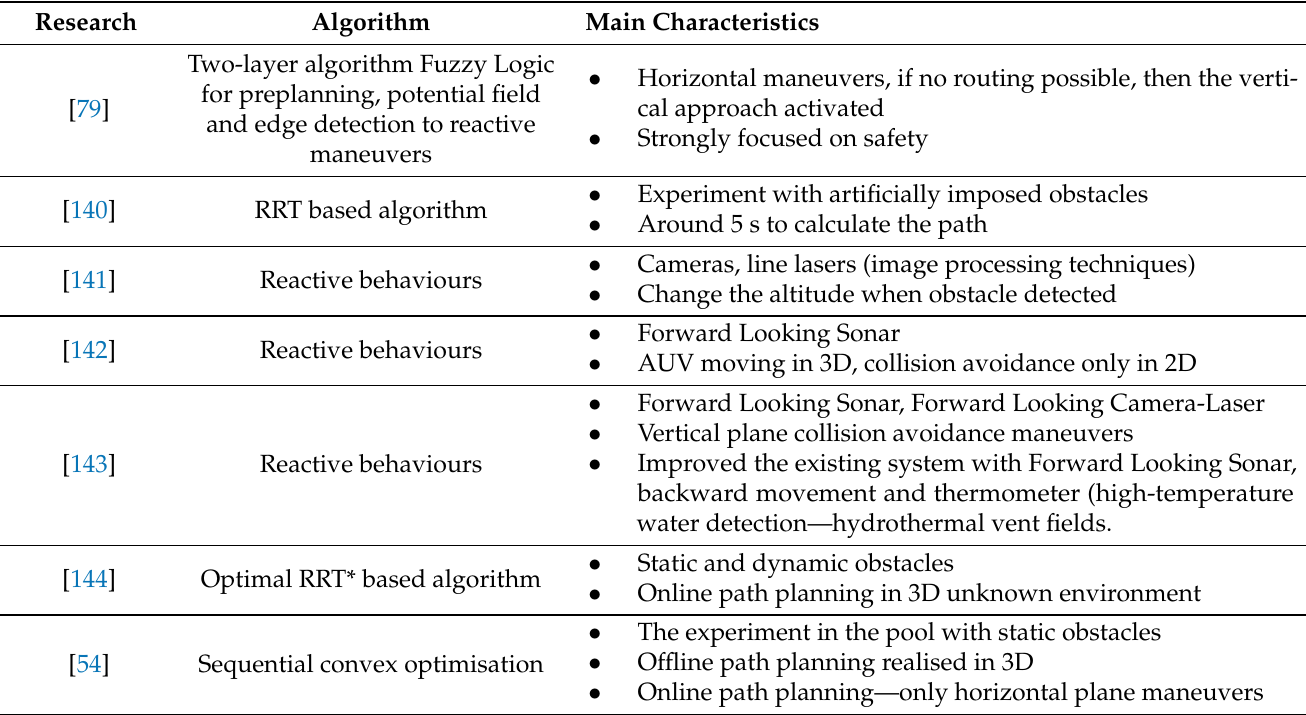
Table 7. List of algorithms in real applications between 2016–2020. Main